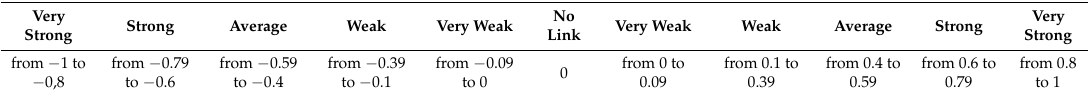
Table 9. Scale of correlation coefficient